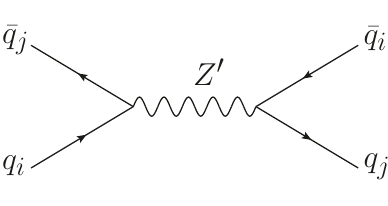
Figure 16 . Meson mixing process induced by a tree level Z 0